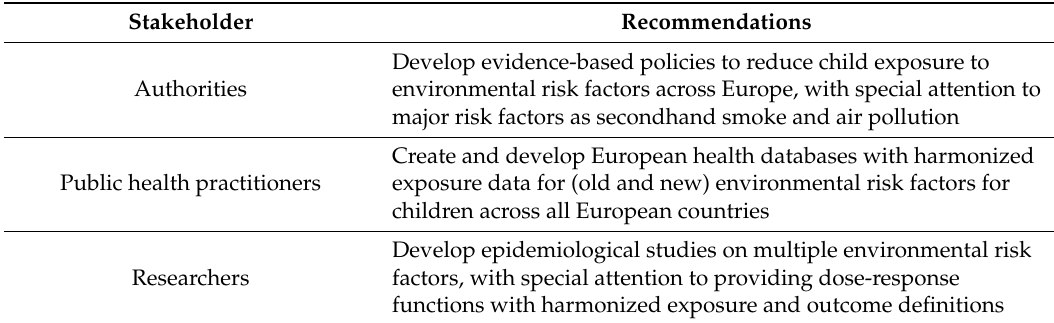
Table 3. Recommendations for authorities, public health practitioners, and